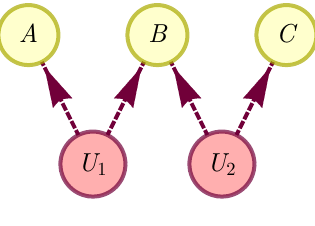
Figure 2: The three-on-line correlation